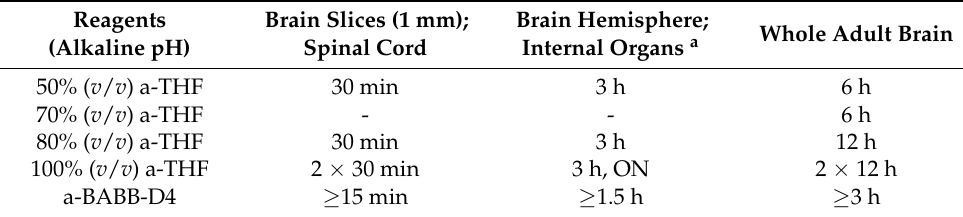
Figure 1. Comparison of the fluorescence preservation performance of tDISCO and other solvent- based clearing methods. AAV2-Retro-EGFP was injected bilaterally in the C4/5 segment. ( A ) The schema shows virus injection, brain slice preparation and clearing procedure. One-millimeter-thick brain slices were collected 2 w after injection. ( B ) Quantitative analysis of the fluorescence level (0 d~56 d) in each group after clearing. ( C ) Time course of fluorescent intensity after tDISCO clearing compared with 3DISCO, uDISCO, and FluoClearBABB clearing methods. All images are presented as maximum intensity projection (MIP) of z-stack (81 µ m thickness, n = 3 slices per method). Scale bars: 50 µ m. All data are shown as means ± SD. * p < 0.05, ** p < 0.01, and *** p < 0.001. Table 1. Clearing protocols for different